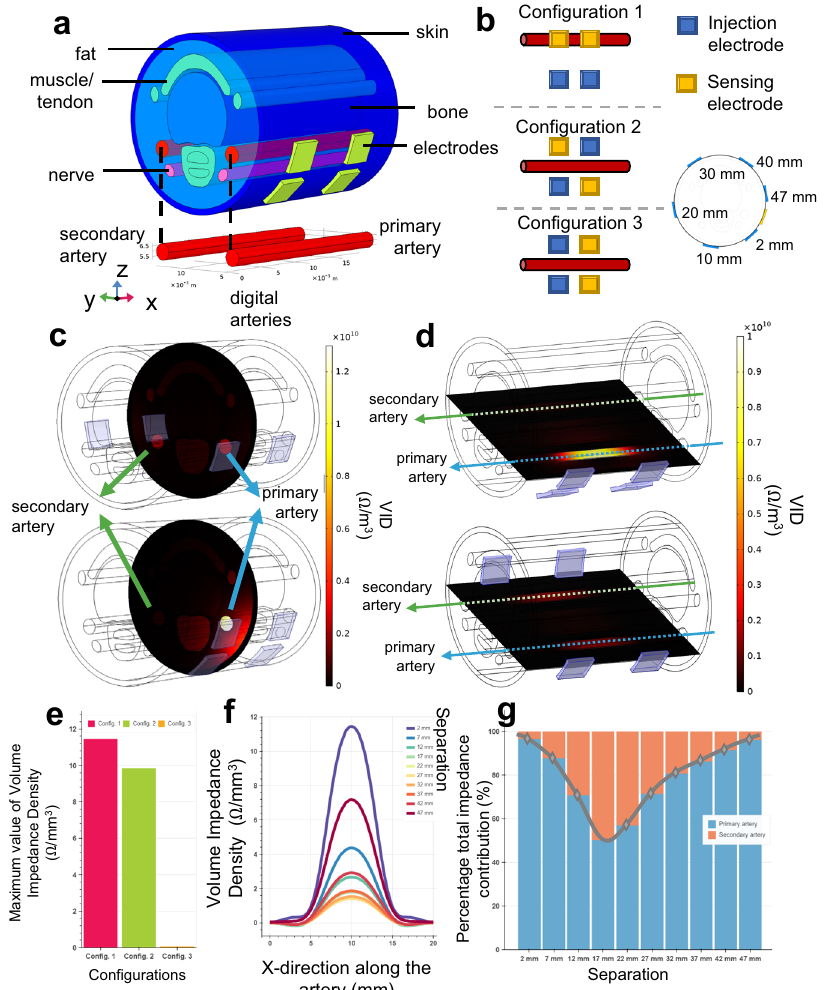
Fig. 2 Finite element model of the fi nger and its electrical simulations. a Three-dimensional fi nger model scaled for US-7 ring form factor, with six different tissue layers (i.e., skin, fat, bone, artery, nerve, muscle) and metal electrodes with complex electrical characteristics de fi ned for each material type. b Three electrode con fi gurations that exhausts possible combinations of electrical current injection and voltage sensing electrodes used in 4-point bioimpedance sensing. c , d Volume impedance density (VID) surface plots for y-z (vertical cut of the artery from the middle point) and x-y planes (horizontal cut along the artery), respectively, where top plots and bottom plots show the VID with 22 mm and 2 mm electrode separation. In both cases, the primary artery VID contribution is higher with smaller electrode separation, shown as in brighter color. e Maximum values of the VID measured from the primary artery for different con fi gurations (Con fi g.), where the highest value obtained with Con fi guration 1 (pink) compared to Con fi gurations 2 (green) and 3 (orange). f VID distribution along the primary artery for different electrode separations. The highest values are obtained with 2 mm electrode separation. Colors indicate the separation. g Percentage total impedance distribution between the primary (blue) and secondary (orange) arteries calculated from the volume integral of the VID measured per artery. In agreement with other analysis types, the highest speci fi city for the primary artery is achieved with 2 mm the blood fl ow) and speci fi city (i.e., sensitivity distribution silver dry electrodes with only two electrodes sitting along the between the primary and the secondary artery) pro fi les (see artery and the remaining two placed in parallel. Three main Methods). Figure 2e shows the maximum values of VID measured combinations arise when assigning the injection and sensing along the primary artery comparing all three con fi gurations. We connections to the electrodes, as shown in Fig. 2b. For observe that Con fi guration 1 provides the highest sensitivity Con fi guration 1, the voltage sensing electrodes are fi xed over among all three con fi gurations, while Con fi guration 3 shows a the primary artery while the current injecting electrodes are signi fi cantly poor sensitivity, possibly due to the orthogonal spaced 2 mm apart. Con fi gurations 2 and 3 both have the placement of injection and sensing electrodes with respect to the electrodes placed symmetrically centering the artery with a underlying artery. Additionally, we tested the effect of physical vertical distance: Con fi guration 2 has the voltage and sensing separation between the injection and sensing electrode pairs with pairs diagonal from each other while Con fi guration 3 has the pairs Con fi guration 1 through a sweep of distances (2 mm to 47 mm, across the artery from each other. with a 5 mm step), allowing the electrode set to go almost We simulated the whole geometry for each con fi guration at the completely around the fi nger with a 55 mm diameter. For each operating frequency of 10 kHZ 13 and measured the volume separation, we captured the VID pro fi les (i) along the primary and impedance density (VID) giving the local impedance contributions secondary arteries, (ii) over the vertical slice in y – z plane cutting to the total bioimpedance using the principle of reciprocity 26,27 . the geometry in middle at x axis, and (iii) over the horizontal slice VID along the artery provides the bioimpedance sensitivity (i.e., to